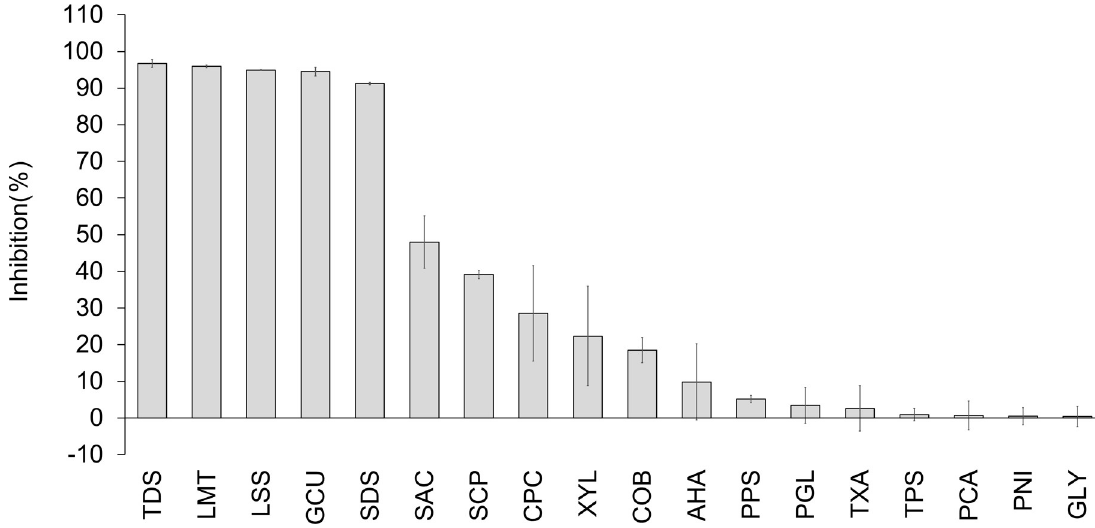
Fig 1. Screening of toothpaste and mouthwash ingredients exhibited inhibitory effects on the interaction between the spike protein RBD of SARS-CoV-2 and ACE2. Eighteen toothpaste and mouthwash ingredients at 1% (w/w) exhibited inhibitory effects interaction between the spike protein of SARS-CoV-2 and ACE2 in vitro . The interaction between the spike protein RBD of SARS-CoV-2 and ACE2 was evaluated by measuring AV at 450 nm using a microplate reader. Data are expressed as the mean ± SD (n = 3).